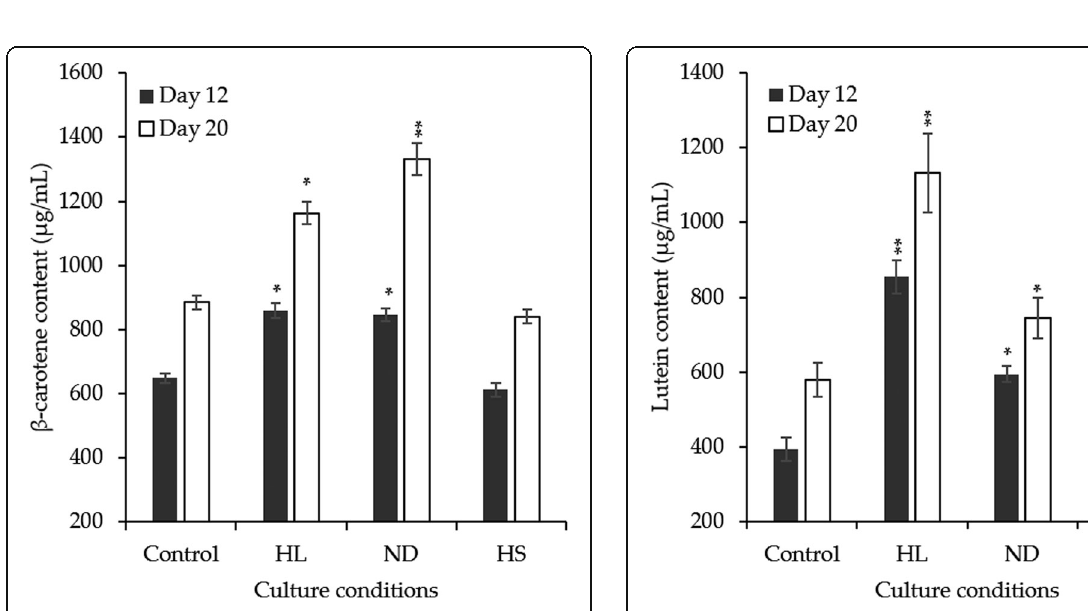
Fig. 5 Lutein content of D. salina Y6 under the tested abiotic-stress conditions. HL, high-light conditions; ND, nitrogen-depleted conditions; HS, high-salt conditions. ** p < 0.01, * p < 0.05. The values represent mean ± S.D. ( n =